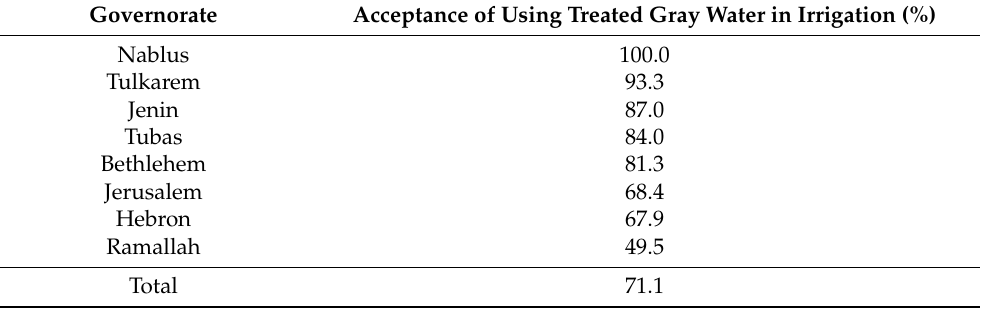
Table 4. Acceptance of using treated gray water in irrigation per governorate.